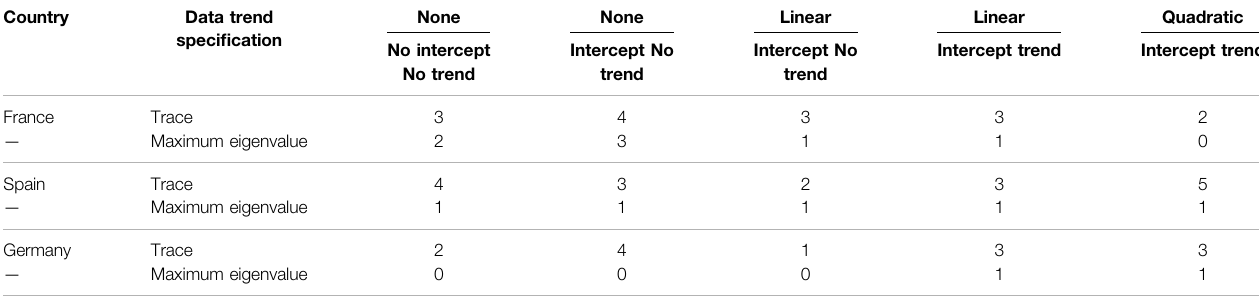
TABLE 9 | Results of the Gregory and Hansen (1996) cointegration test. Country Constant Constant and trend Constant and slope Constant,